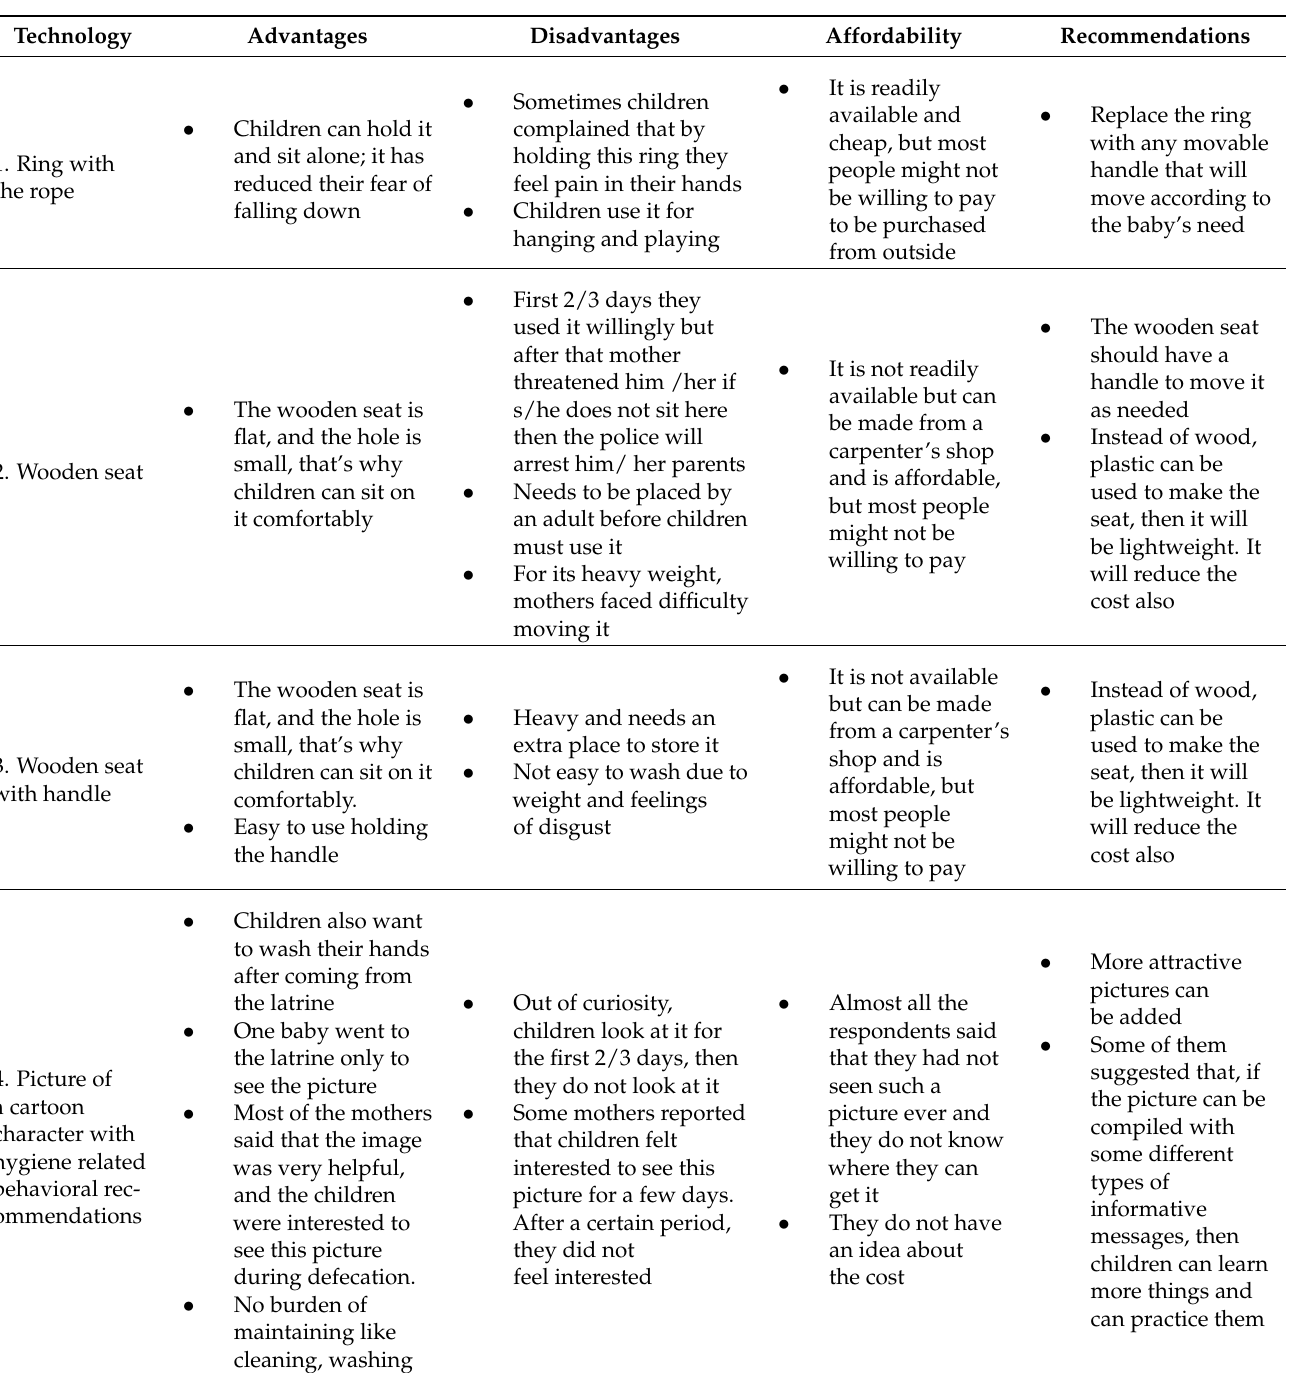
Table A1. Key findings from two rounds of Trial of Improved